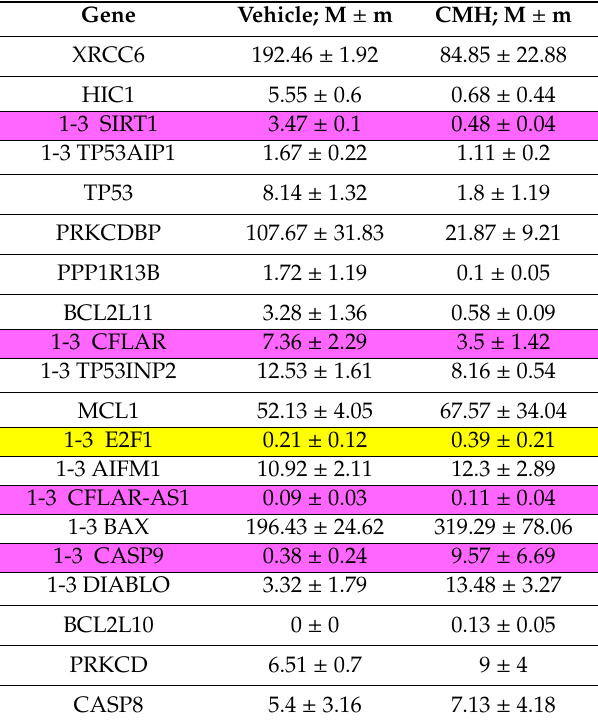
Table 1. Expression of specific genes in IPF myofibroblasts of CCL-191 line incubated with CMH and the vehicle, correspondingly, calculated by 2 − ∆∆ Ct , the data are represented as mean ± standard error of the